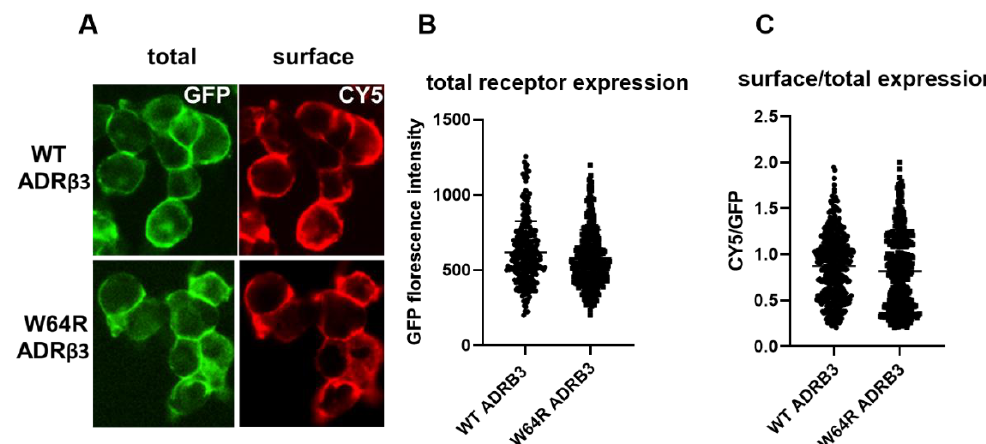
Figure 2. Total and cell surface expression of WT and W64R variant of ADR β 3 . ( A ) Imaging showing GFP (total) and CY5 (cell surface) expression of WT and W64R ADR β 3 ( B , C ) Single cell analysis showing total ( B ) and cell surface expression ( C ) of WT and W64R ADR β 3. Each graph represents analysis of at least 100 cells across multiple experiments.